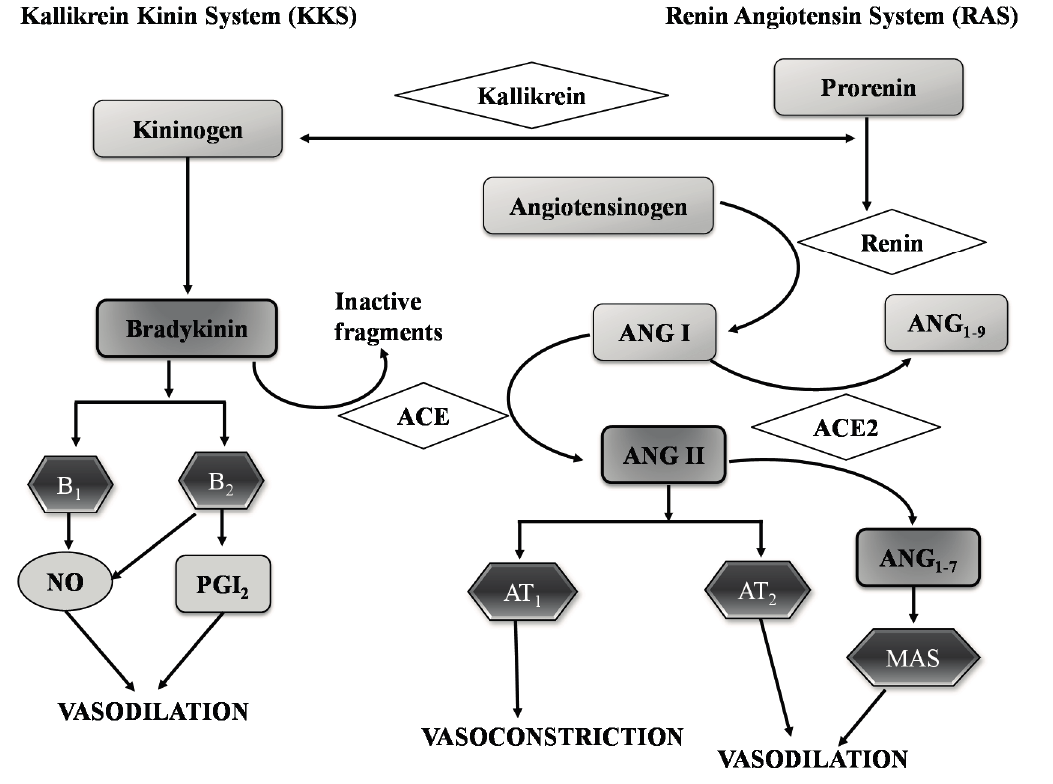
Figure 1. Renin-angiotensin system and kallikrein kinin system to regulate of blood pressure. Angiotensin I (Ang I), Angiotensin II (Ang II), Angiotensin converting enzyme (ACE), Angiotensin converting enzyme 2 (ACE 2), Angiotensin receptor 1 (AT 1 ), Angiotensin receptor 2 (AT 2 ), Bradykinin receptor 1 (B 1 ), Bradykinin receptor 2 (B 2 ), Nitric oxide (NO), Prostaglandins 2 (PgI 2 ). Figure 1 modified from